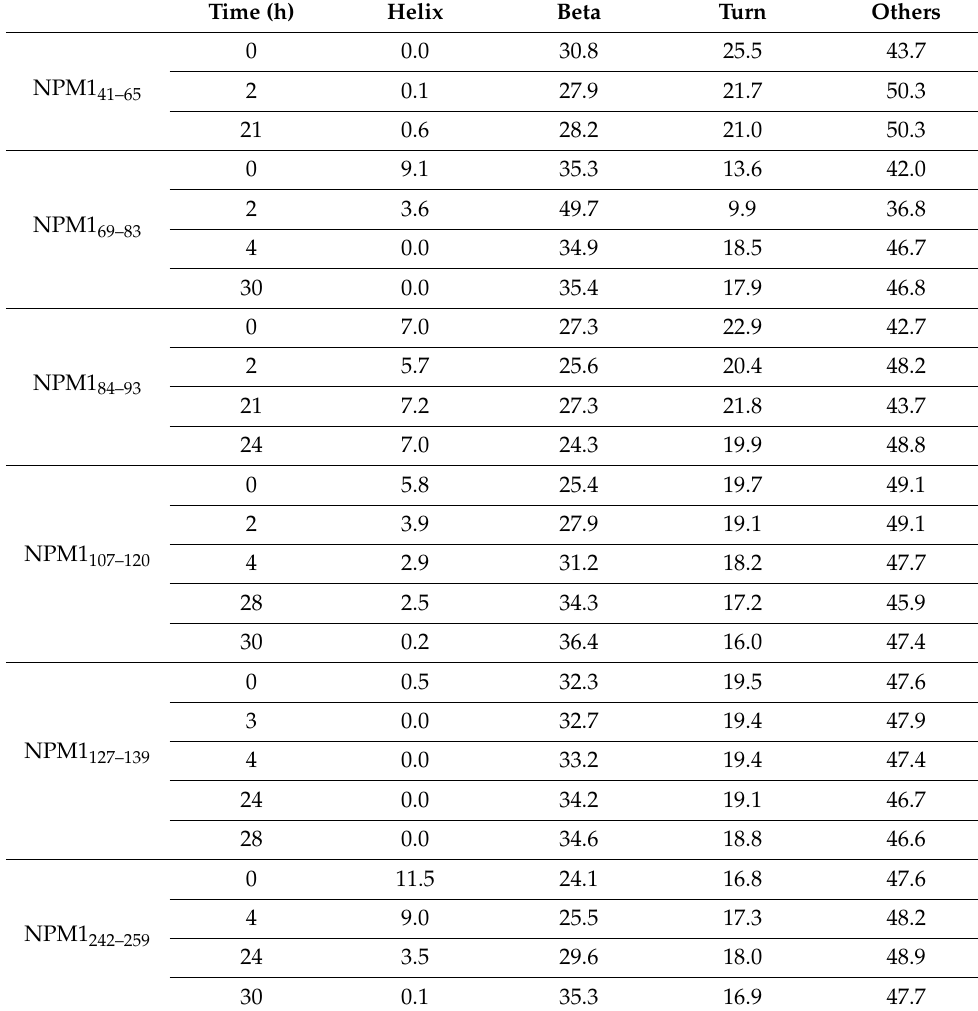
Table 2. Deconvolution of CD spectra of all peptides at indicated times. Time